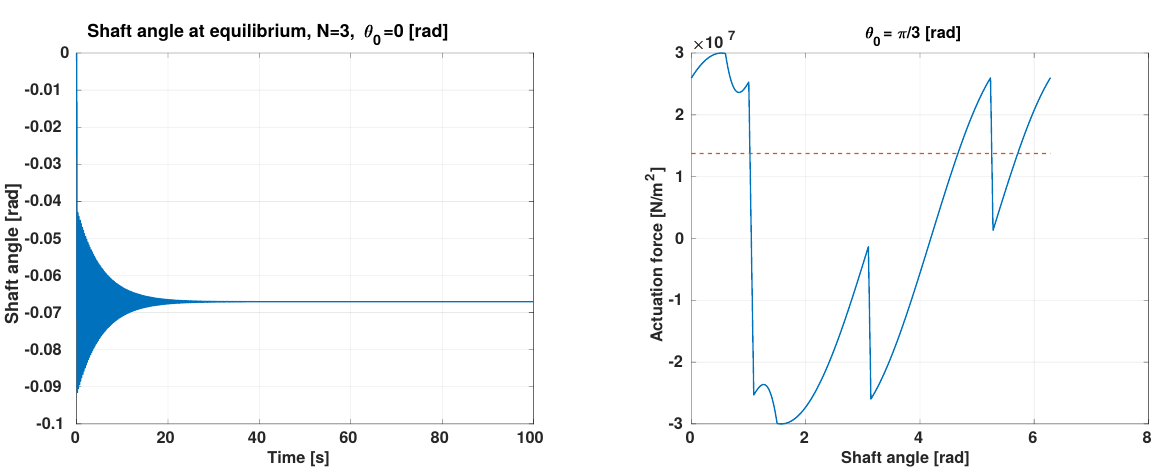
Figure 3: Equilibrium point when initial angle is 0 [rad], from the simulation model.